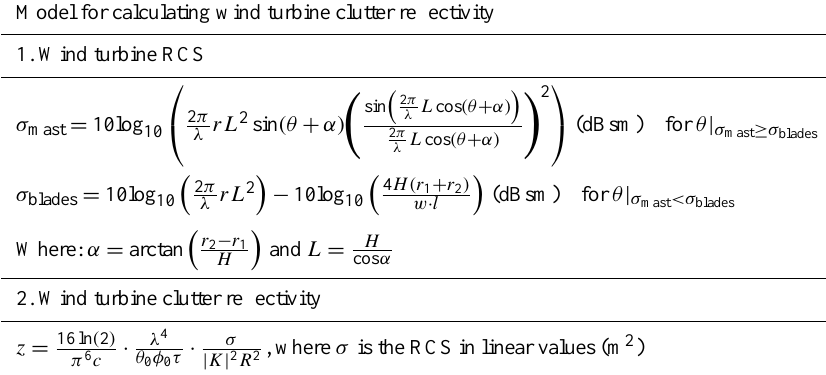
Table 5. Simplified model for estimating WTC reflectivity in weather radar bands. Model for calculating wind turbine clutter